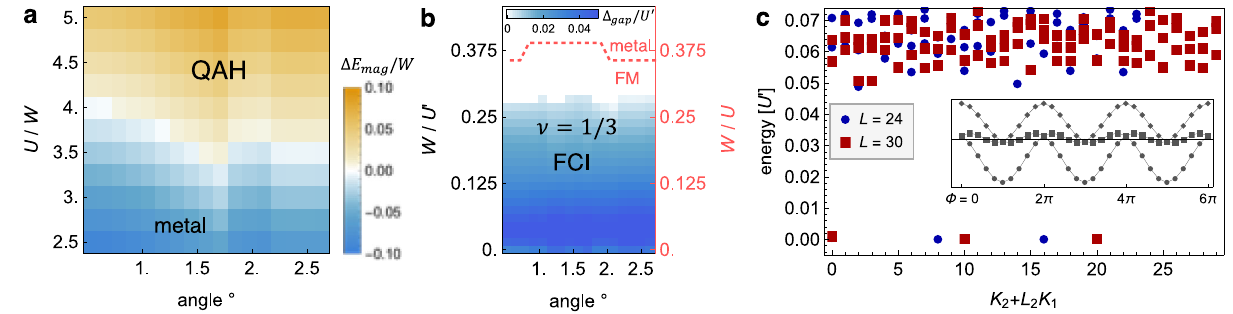
Fig. 4 Quantum anomalous Hall effect and fractional Chern insulators. a At half fi lling, the fi rst moiré band displays a ferromagnetic instability for a local Hubbard repulsion U on the order of ~4 W the electronic bandwidth, depicted via the energy density gain from spontaneous spin polarization. Spin-polarized moiré quantum spin Hall bands realize a correlated quantum anomalous Hall phase. b At 1/6 hole doping, ferromagnetism (FM) persists for fi nite U [right axis] over a wide range of twist angles. Finite longer-ranged Coulomb repulsion U 0 [left axis] between nearest-neighbor Kagome sites drives this spin- polarized metal into a ν = 1/3 Laughlin phase, realizing a robust fractional Chern insulator, depicted in terms of the many-body excitation gap. c Fingerprint of the fractional Chern insulator in the low-energy spectrum for L = 24 ( L = 30) unit cells with periodic boundary conditions and N = 8 ( N = 10) fermions, depicted as a function of linearized total momentum ( K 1 , K 2 ). Inset depicts the characteristic spectral fl ow under insertion of a magnetic fl ux through the